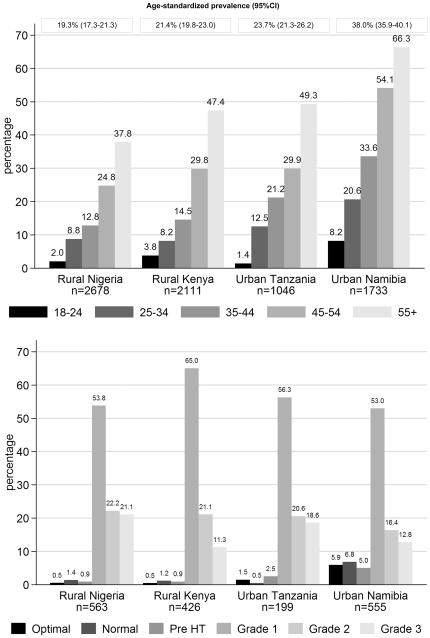
Hypertension prevalence and distribution of blood pressure.2A: Age-standardized and age stratified hypertension prevalence. 2B: Distribution of blood pressure in patients with hypertension (treated and untreated cases). Optimal  =  systolic blood pressure (SBP) <120 and diastolic blood pressure (DBP) <80; Normal  =  SBP 120–129 and/or DBP 80–84; Pre-HT (hypertension)  =  SBP 130–139 and/or DBP 85–89; Grade 1 =  SBP 140–159 and/or DBP 90–99; Grade 2 =  SBP 160–179 and/or DBP 100–109; Grade 3 =  SBP> = 180 and/or DBP> = 110.